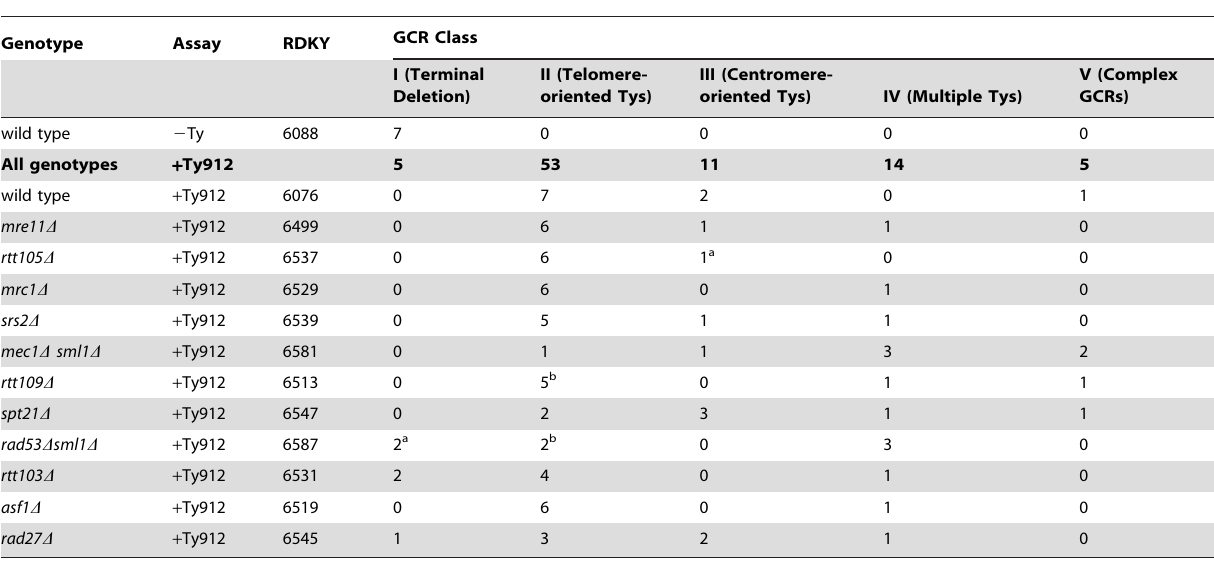
Table 2. Summary of GCR events determined by aCGH data.